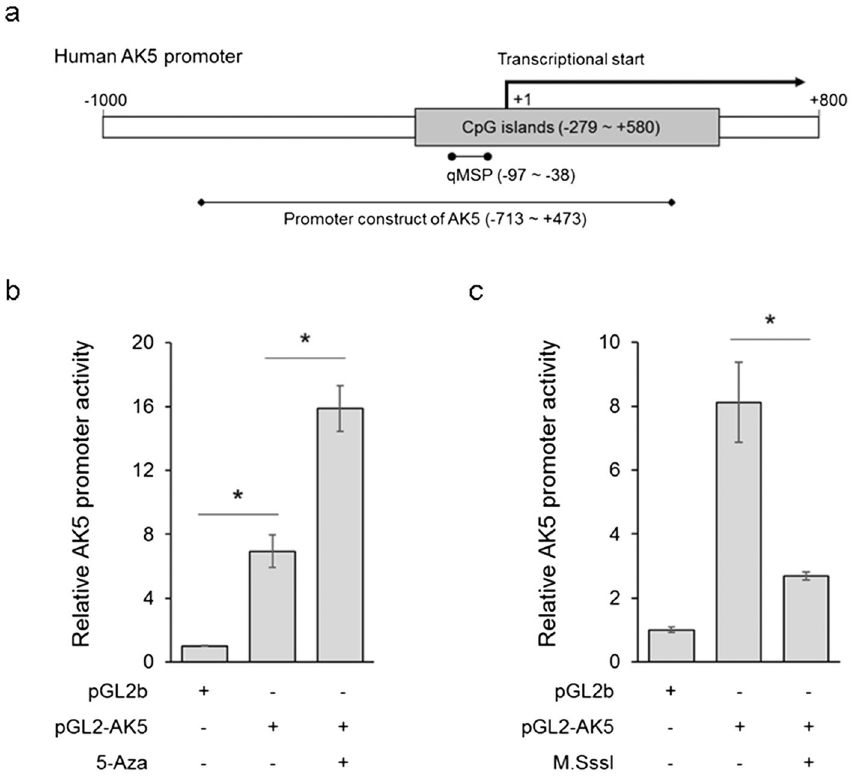
Figure 3. The activity of AK5 promoter regions in CRC cells. The AK5 promoter activity was observed using luciferase assay in DLD-1 cells. ( a ) The human AK5 promoter structures are schematically shown including the designed region of the AK5 promoter construct and AK5 qMSP primer design site containing the CpG island. ( b ) The pGL2-AK5 promoter is highly activated compared to pGL2b. The pGL2-AK5 promoter is significantly activated by 5-aza. ( c ) The AK5 promoter methylated by M.SssI showed significantly decreased promoter activity compared to the normal AK5 promoter in DLD-1 cells. pGL2b luciferase vector was used as the negative control. *P-values of < 0.05 were considered statistically